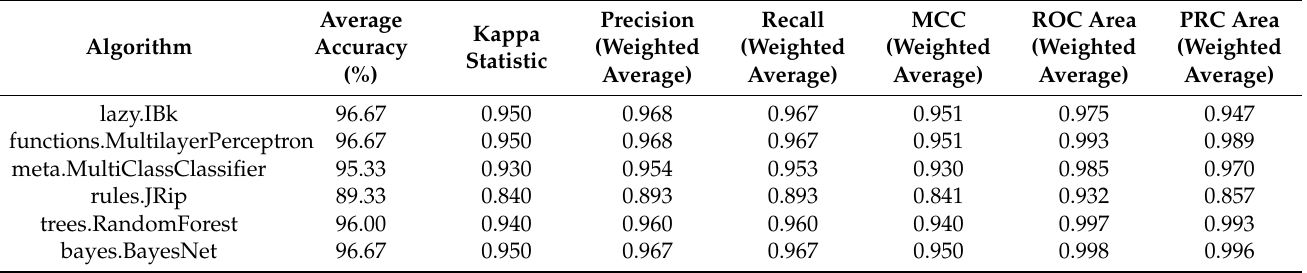
Figure 2. The confusion matrices of the classification of three classes of black currants, namely unstored (room 0) and stored at room temperature for 1 week (room 1) and 2 weeks (room 2), based on selected image textures from color space RGB using models developed using the IBk ( a ) and JRip algorithms ( b ). Table 2. The results of the classification of black currants (unstored, stored in the refrigerator for one week and two weeks) using models developed based on selected image textures from color space RGB using algorithms from different